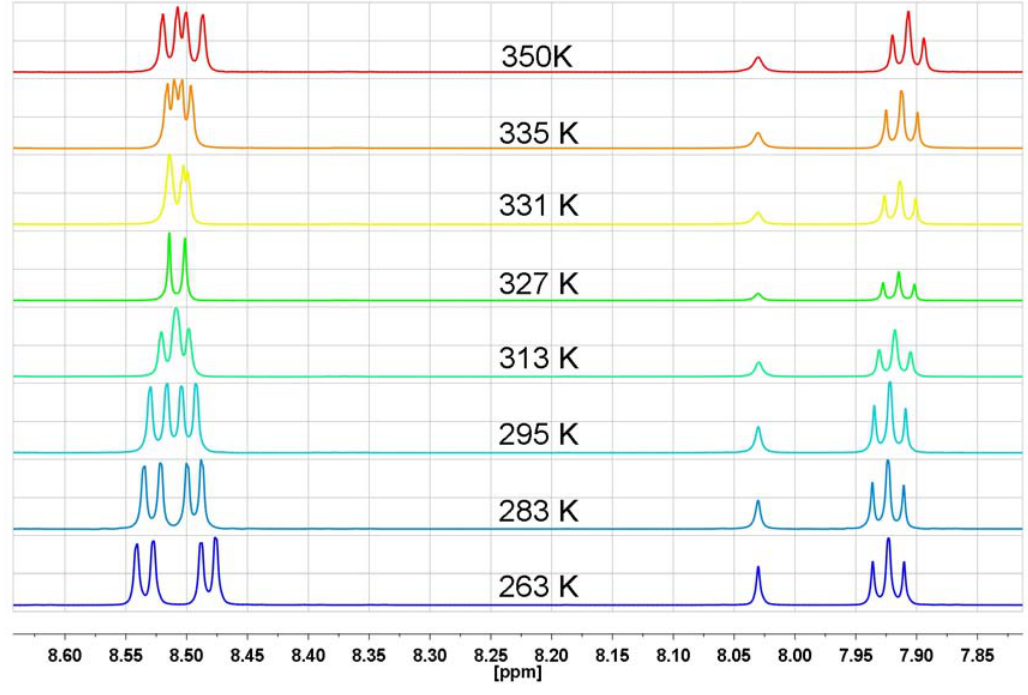
for N -ethyl- N,N 7